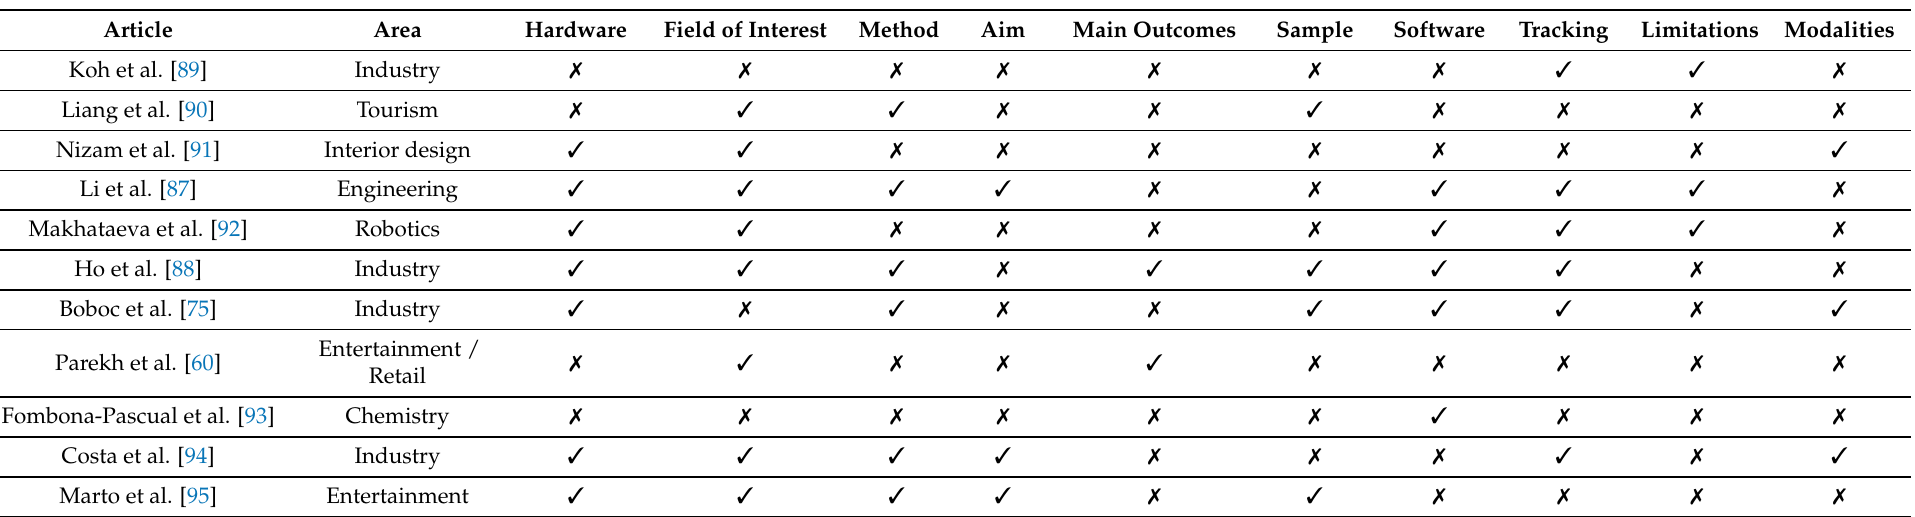
Table 3. Criteria for AR review articles oriented towards other